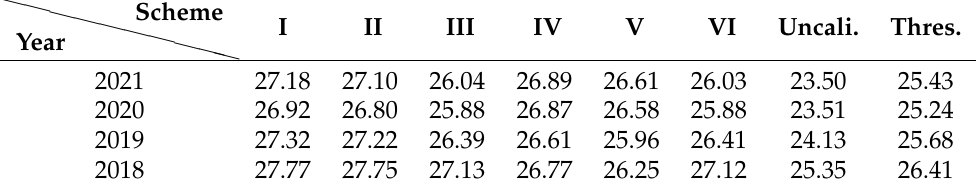
Figure 4. Data density (normalized with respect to the max occurrence) of CyGNSS data over the region covering [95,105] ◦ E and [25,35] ◦ N. Table 1. PSNR (in dB) of Calibrated and Uncalibrated